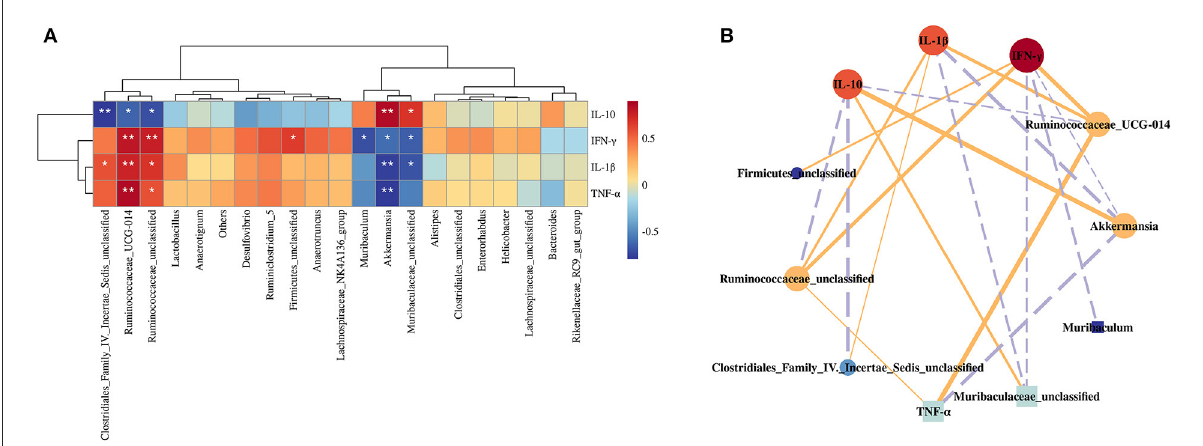
FIGURE6 Correlation analysis between the gut microbiota and inflammation-related indexes. Heatmap (A) and visual network diagram (B) . NC, normal control; MC, model control; PC, positive control; Se-SPP, selenium-containing polysaccharides from Spirulina platensis . TNF- α , tumor necrosis factor; IL-1 β , interleukin-1 beta; IFN- γ , interferon- γ ; IL-10, interleukin-10. The colors range from red (positive correlation) to blue (negative correlation), and significant correlations are marked with * p < 0.05, ** p < 0.01, *** p <